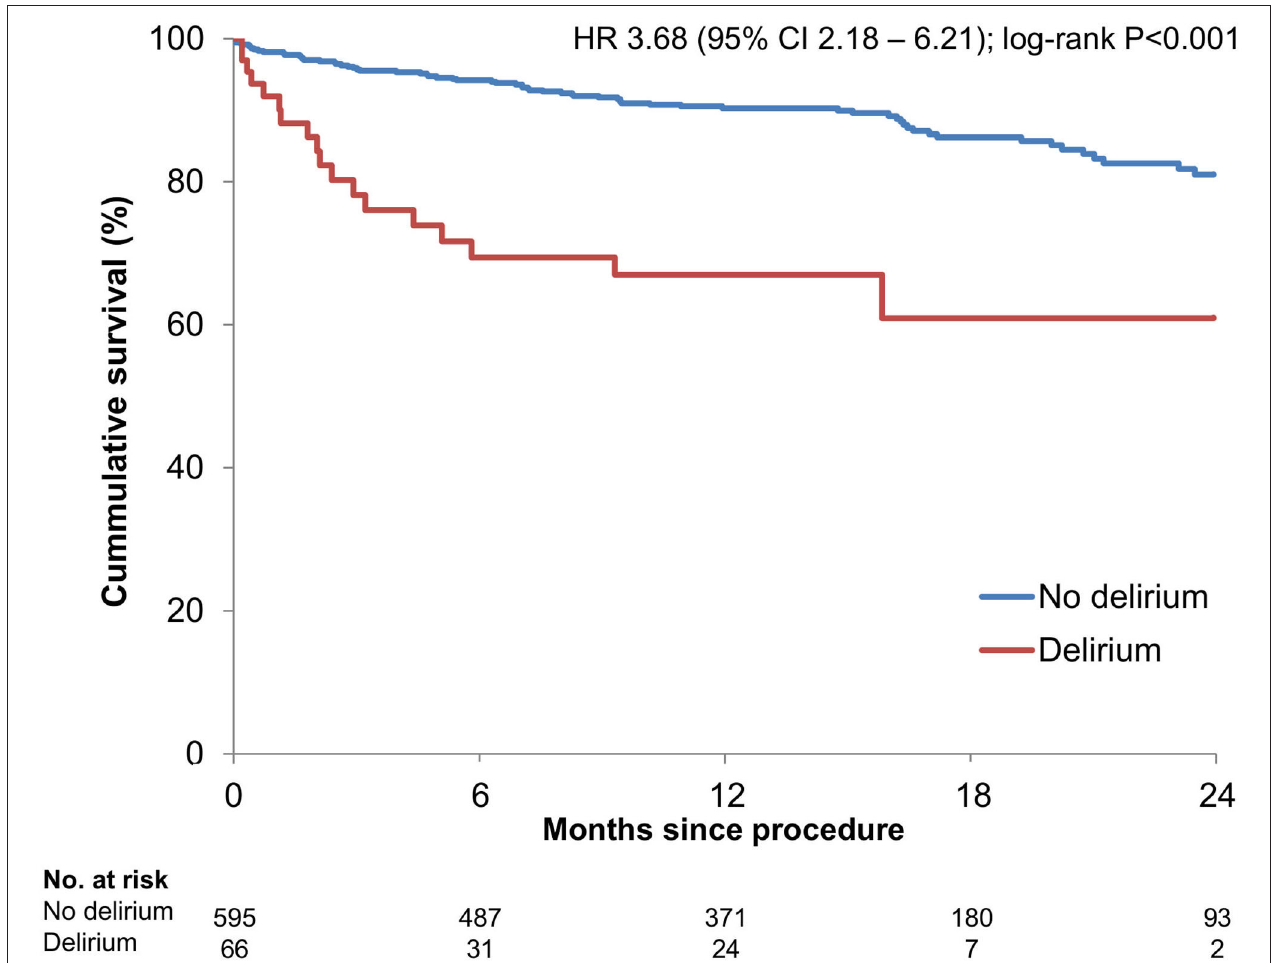
FIGURE 1 | Kaplan Meier survival estimates stratified by postoperative delirium.